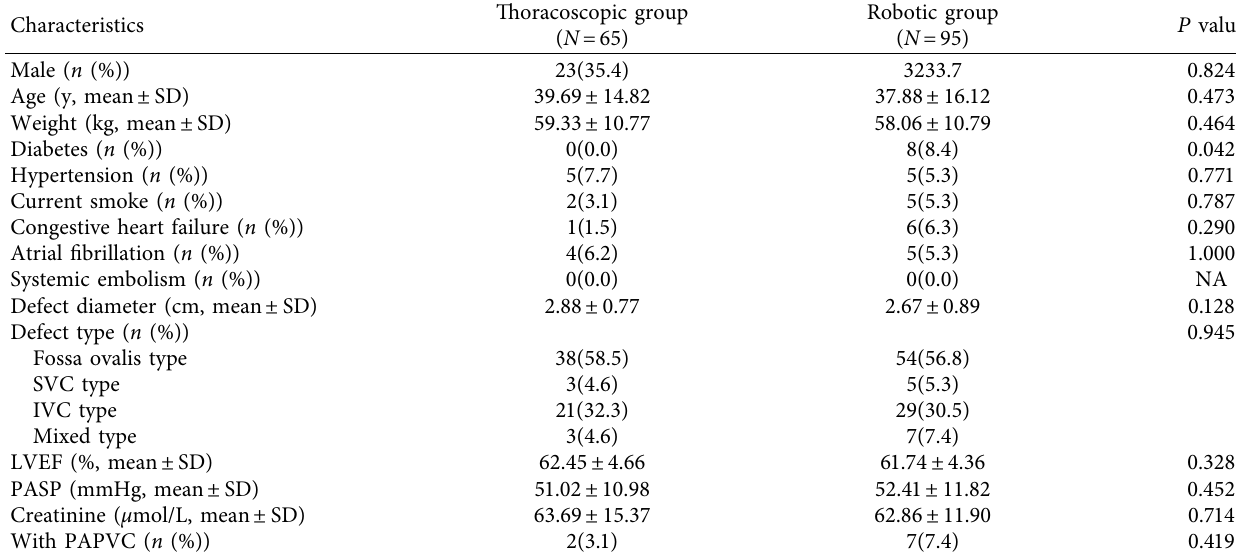
Table 1: Patient baseline characteristics before propensity